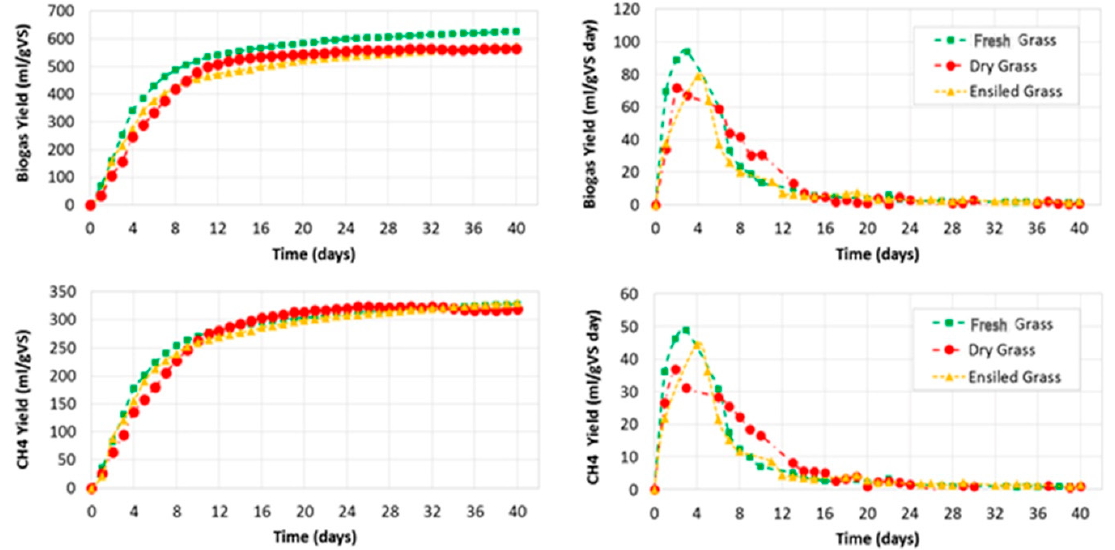
Figure 4. Cumulated and daily biogas yield and CH 4 yield referred to as volatile solids (VS).